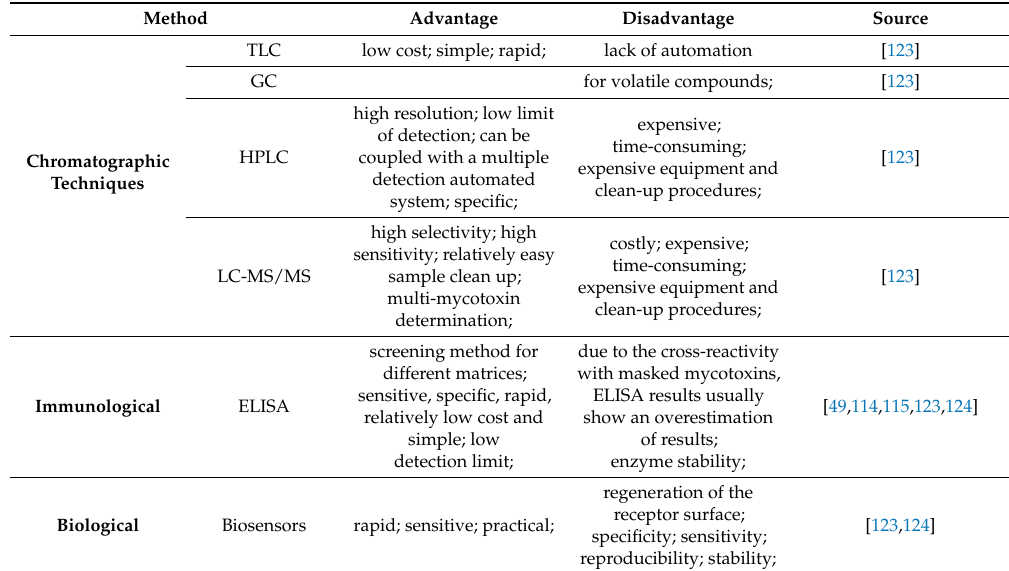
Table 2. Some of the most used methods in mycotoxin detection and